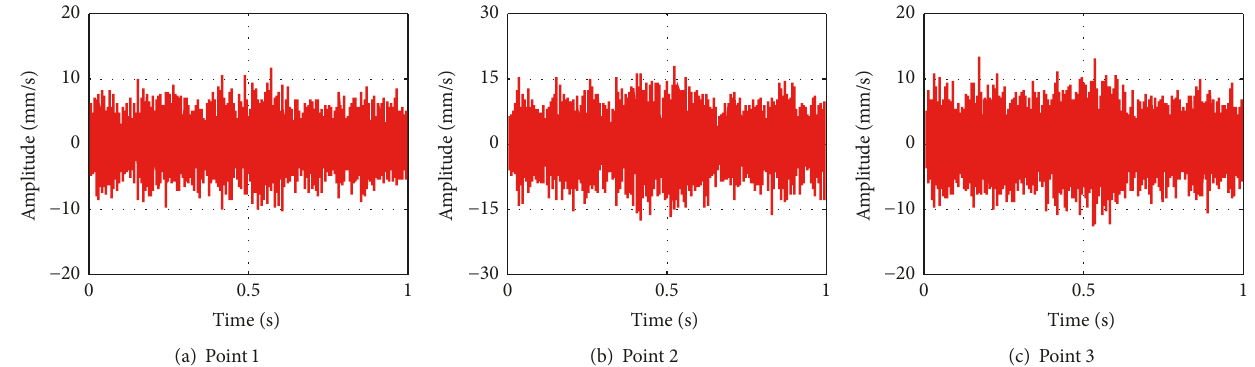
Figure 12: The measured time waveforms of cantilever cylindrical shell with hard coating at 3 measuring points.